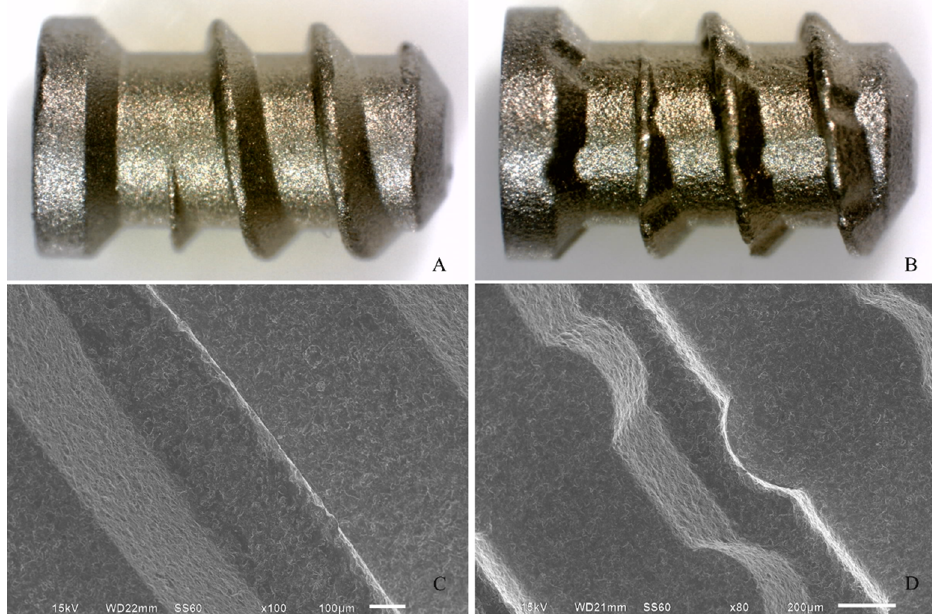
Figure 2. ( A , B ) Stereo microscopy of the implants (3×) for control and test groups, respectively. ( C , D ) Scanning electron microscopy of the implants (80–100×) for control and test groups, respectively.